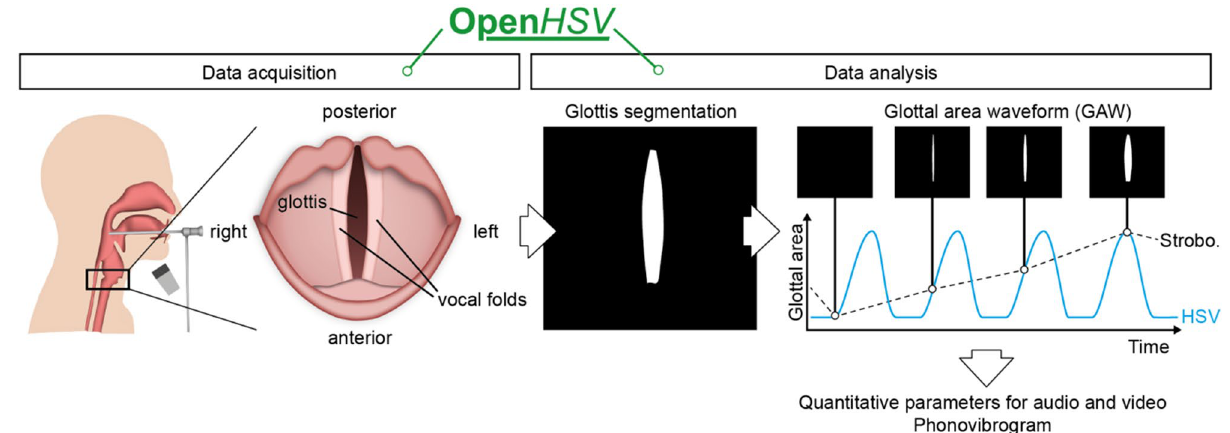
Figure 1. Laryngeal high-speed videoendoscopy is performed with a rigid endoscope yielding a top view of the larynx showing the vocal folds and the glottis. Glottis is segmented for each recorded video frame resulting in the glottal area waveform (GAW, blue). Stroboscopy is limited to single time points of individual cycles (dashed line). Using the GAW and the audio signal, quantitative parameters and the phonovibrogram are